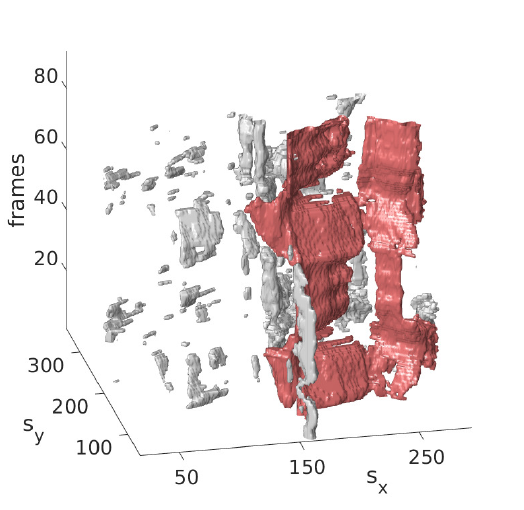
Figure 3. Three frames showing the extraction of the mitral valve (red) from the mis-segmented structures (light gray) by the refinement step.